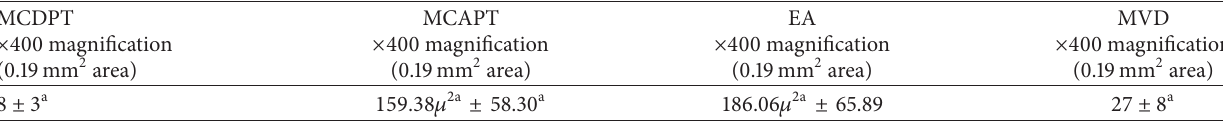
Table 2: MCAPT, MCDPT, EA, and MVD means ± 1 standard